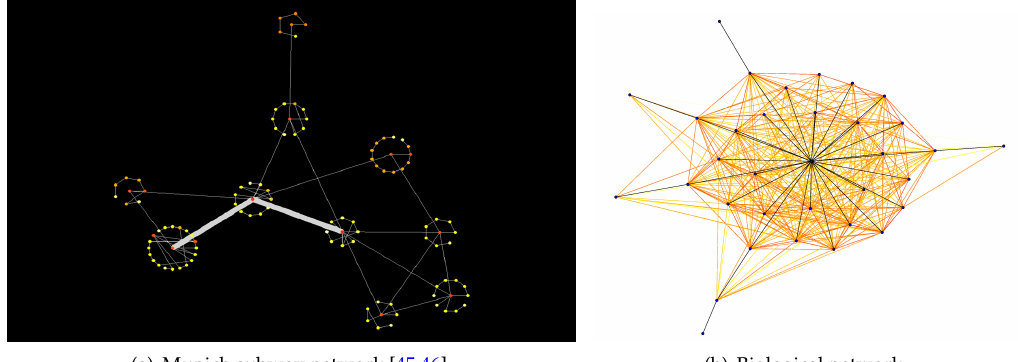
Figure 2. Two different networks representing different